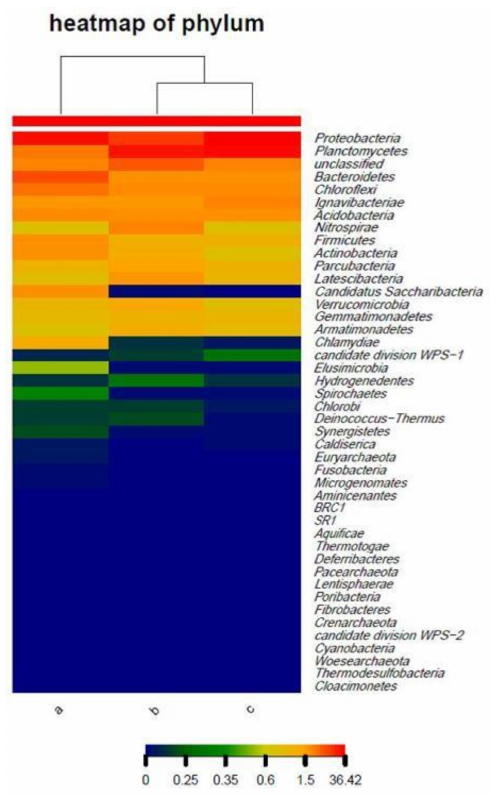
Figure 3. Heatmap of 16S rRNA metagenomics of the microbial populations of a, b, and c samples. Samples a, b, and c were for seed sludge, ASBR sludge, and biofilter reactor sludge, respectively. Color scale from blue (lowest abundance) to red (highest